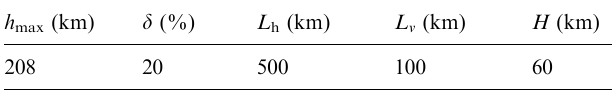
Table 2. Model TID parameters